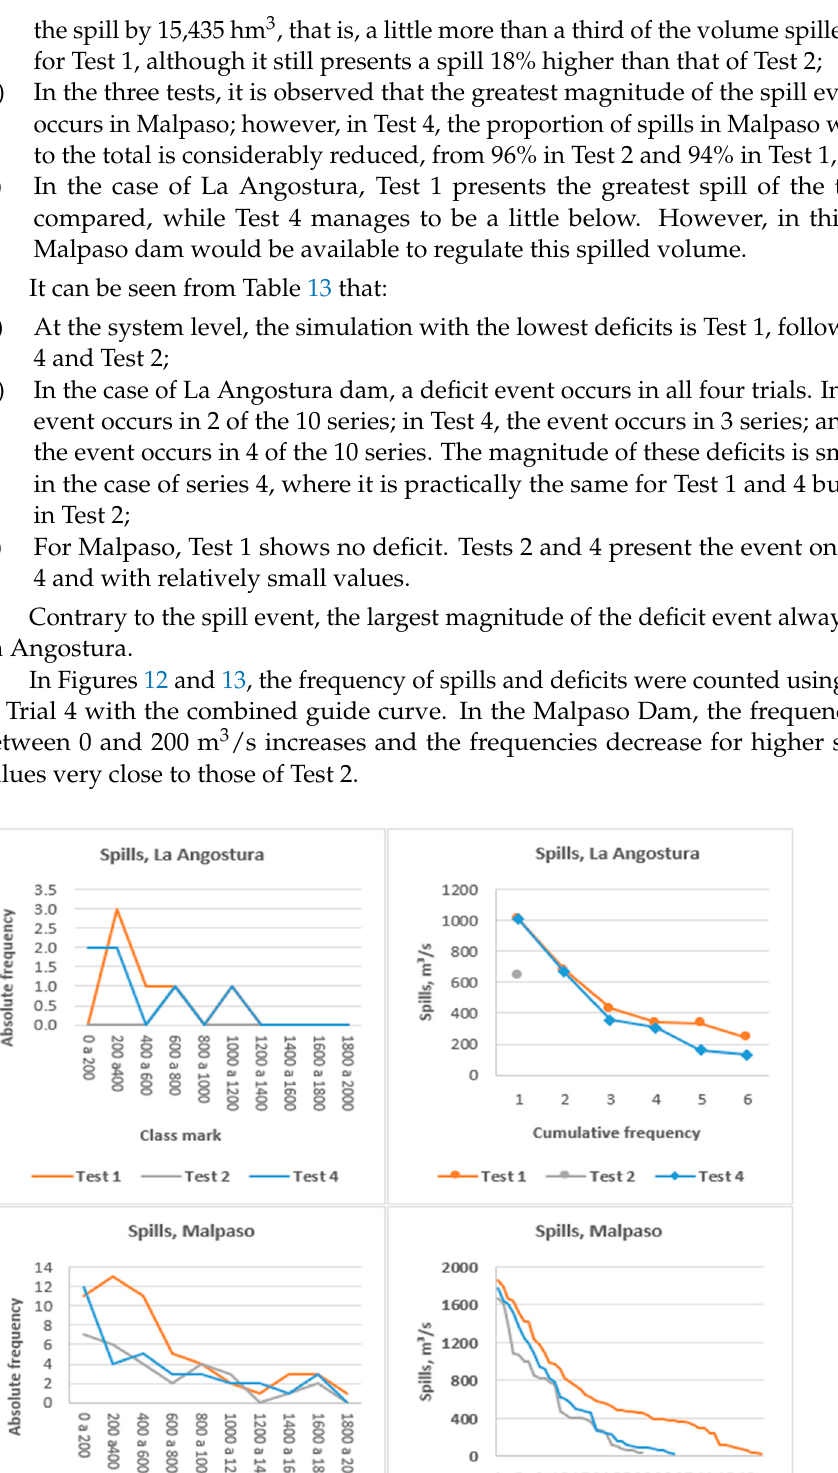
Figure 13. Deficit count with the combined guide curve policy.